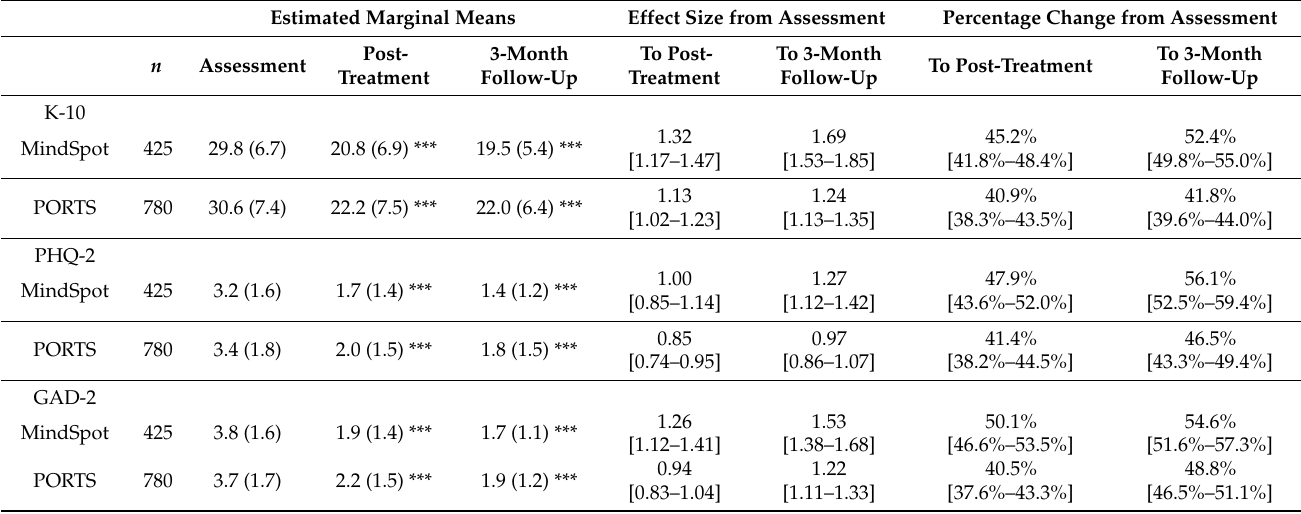
Table 2. Treatment outcomes for patients enrolled in the Wellbeing Course at MindSpot ( n = 425) and PORTS ( n =